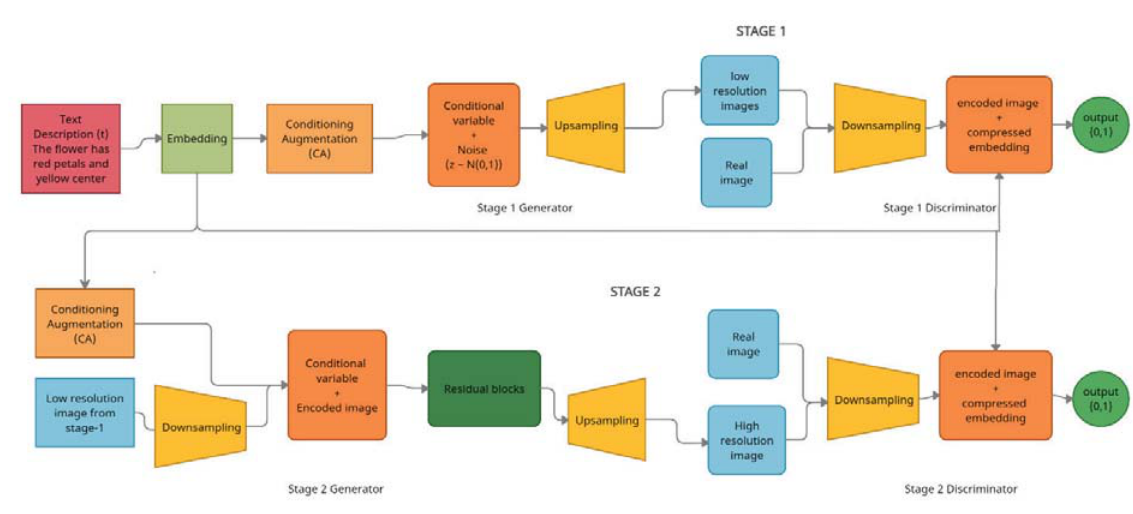
Fig. 4. Stacked GAN model architecture